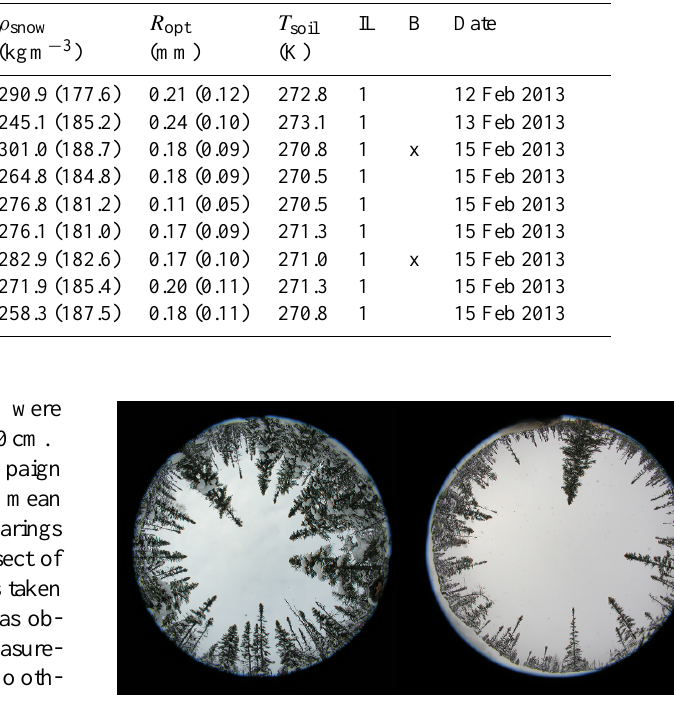
Figure 2. Fisheye pictures for JB veg − 3 . 3 (left) and JB veg − 2 . 2 (right) sites, showing the sky view proportion around the SBR site